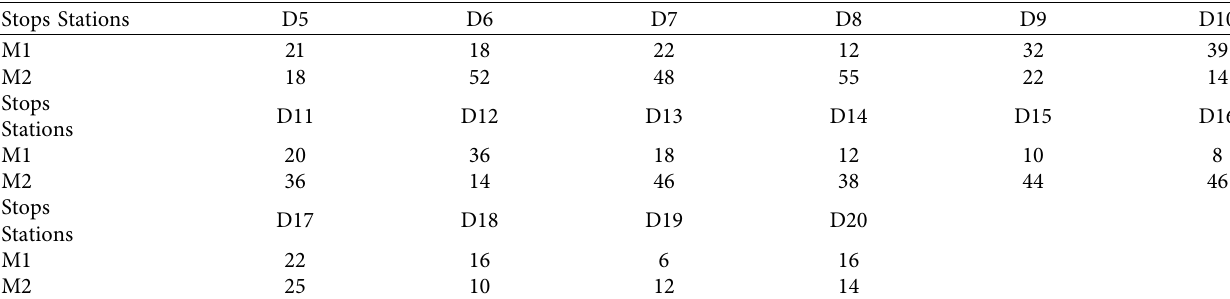
Table 3: Number of passengers from each feeder bus stop to the metro station (unit: